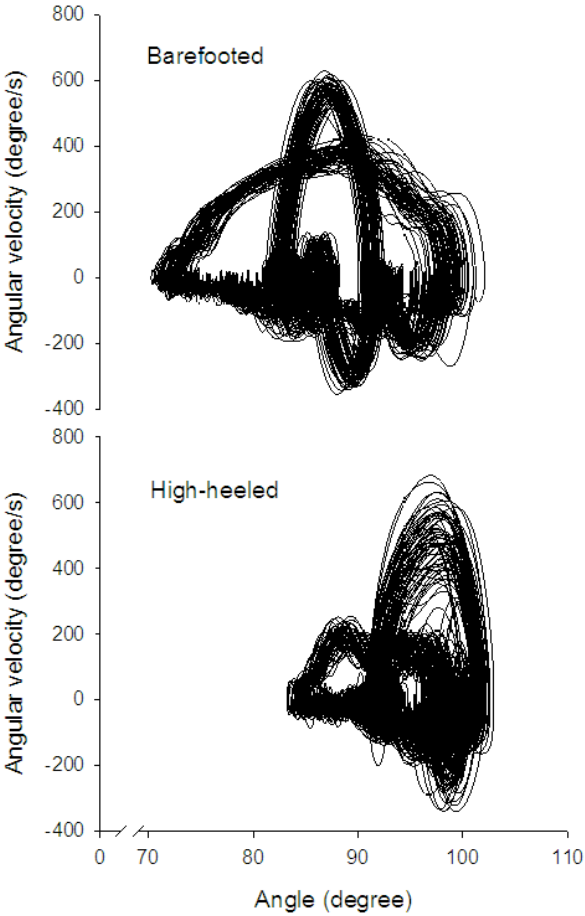
Figure 4. Representative phase portraits from one subject. Two- dimensional state spaces created by plotting the ankle joint position (x- axis; degrees) against the ankle joint angle velocity (y-axis; degrees/s). The ankle joint angle was collected over 60 s of barefooted (top panel) and high-heeled (bottom panel) walking. Note that the trajectories during high-heeled walking (bottom panel) display more divergence than during barefooted walking (top panel).